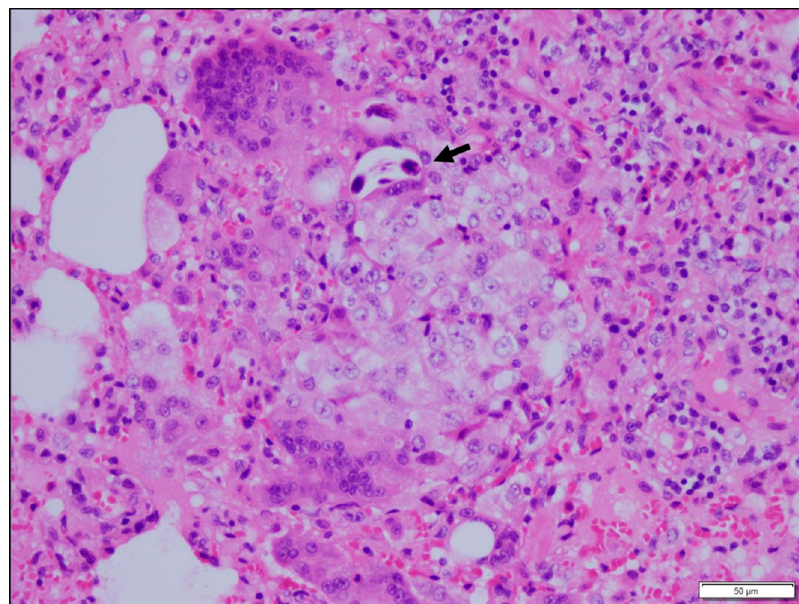
Figure 2. Mongoose 64. Lung. Granuloma with giant cells and epithelioid macrophages. Single nematode in section (arrow).